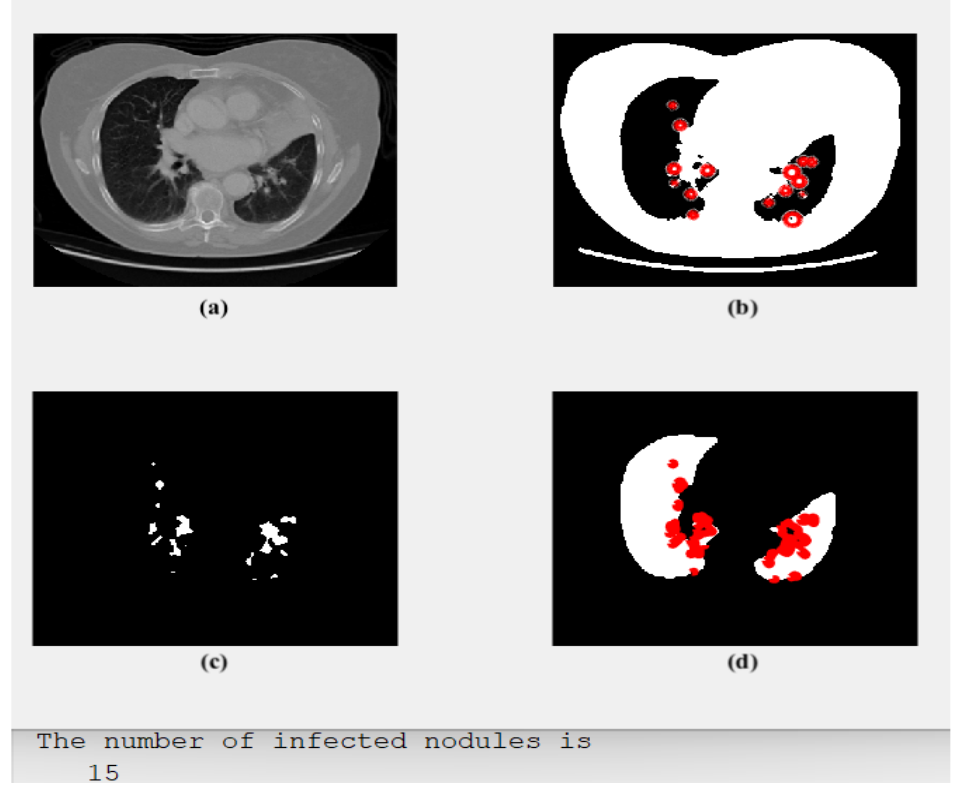
Figure 3. The obtained results of Case 1: ( a ) an input, ( b ) segmented potential RoIs, ( c ) the outlined spots, and ( d ) type of detected tumor: Adenocarcinoma. spots, and ( d ) type of detected tumor: